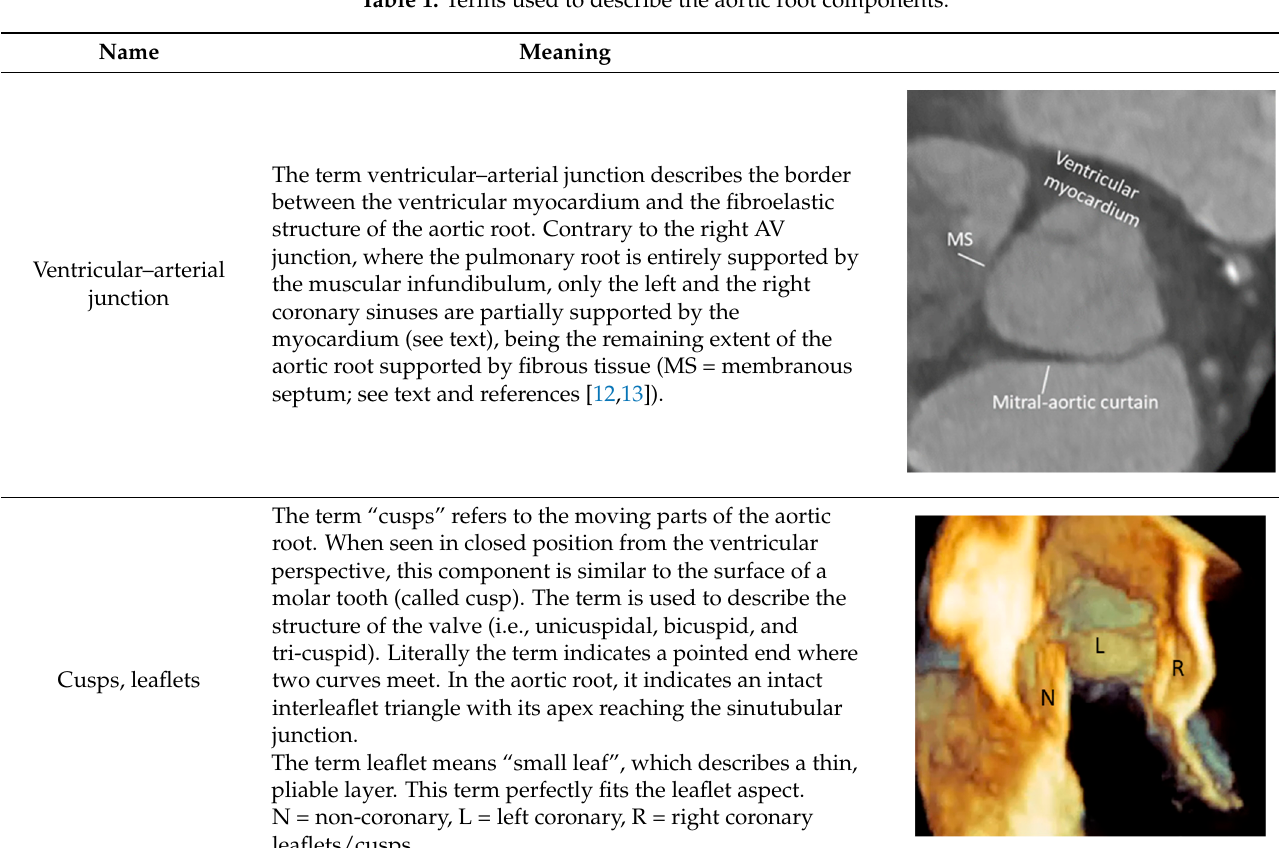
Table 1. Terms used to describe the aortic root